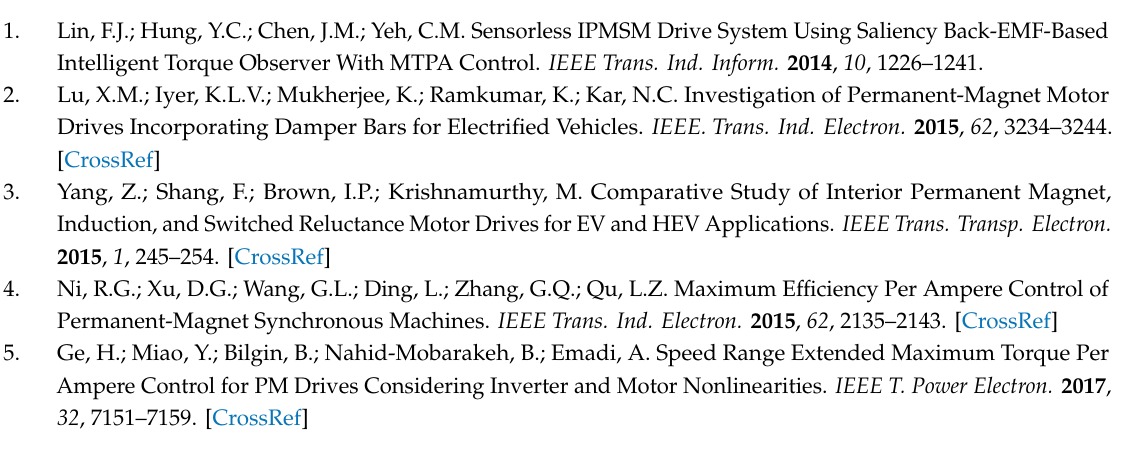
Figure 7. The experiment result: ( a ) reference torque; ( b ) q-axis reference current.